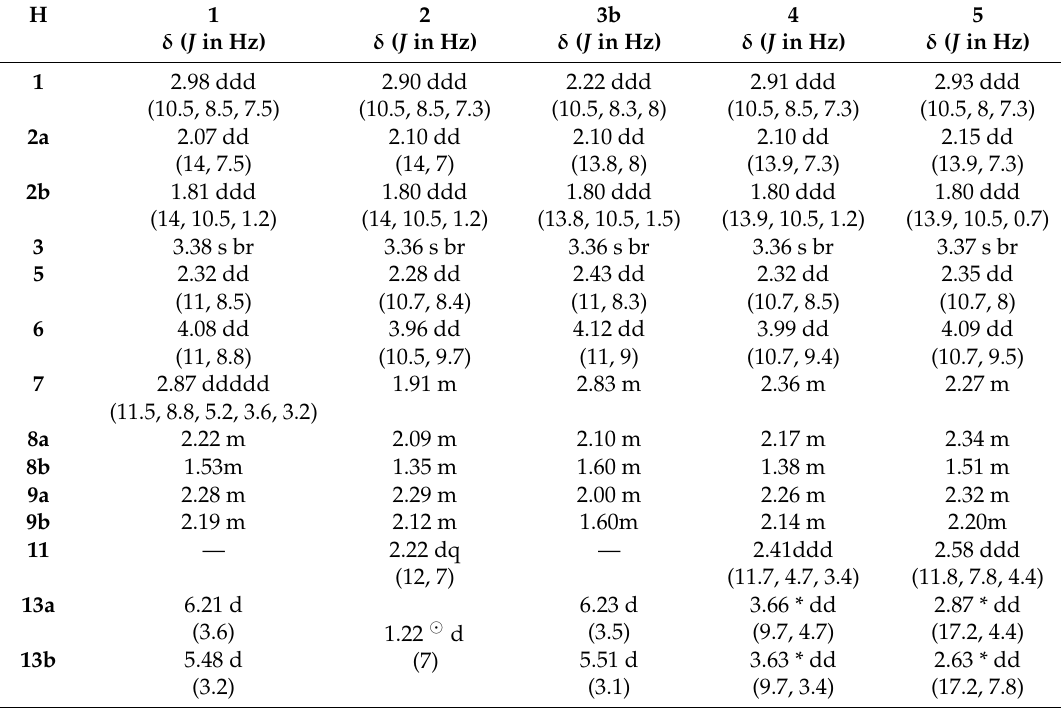
Table 2. 1 H-NMR data of compounds 1 – 5 in CDCl 3 (600 MHz; TMS as internal